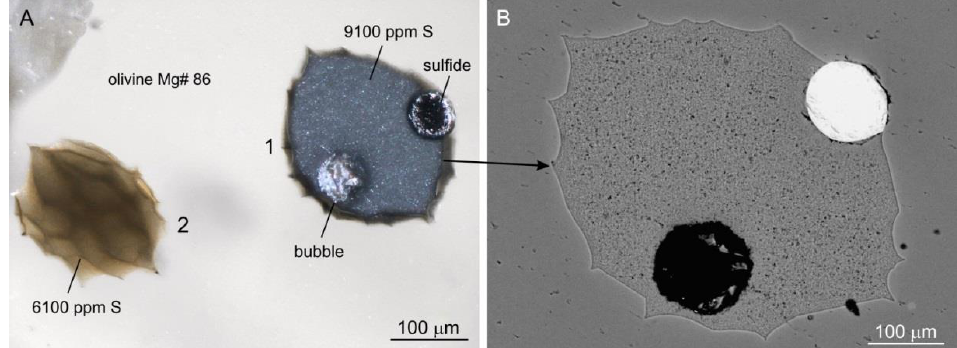
Figure 5. Transmitted light ( A ) and back-scattered electron ( B ) images of two melt inclusions within the olivine crystal are shown in Figure 1C which have different degrees of crystallization despite the same quenching rate. A: Inclusion #1 with higher sulfur (9100 ppm) contains a trapped globule of Fe-Ni-Cu sulfide; the adjacent inclusion #2 with a lower sulfur concentration (6100 ppm) is represented by the brown translucent glass and does not contain visible crystals. B: Melt in inclusion #1 occurred within the fine-crystalline, porous aggregate consisting of clinopyroxene, anhydrite, and acid glass.